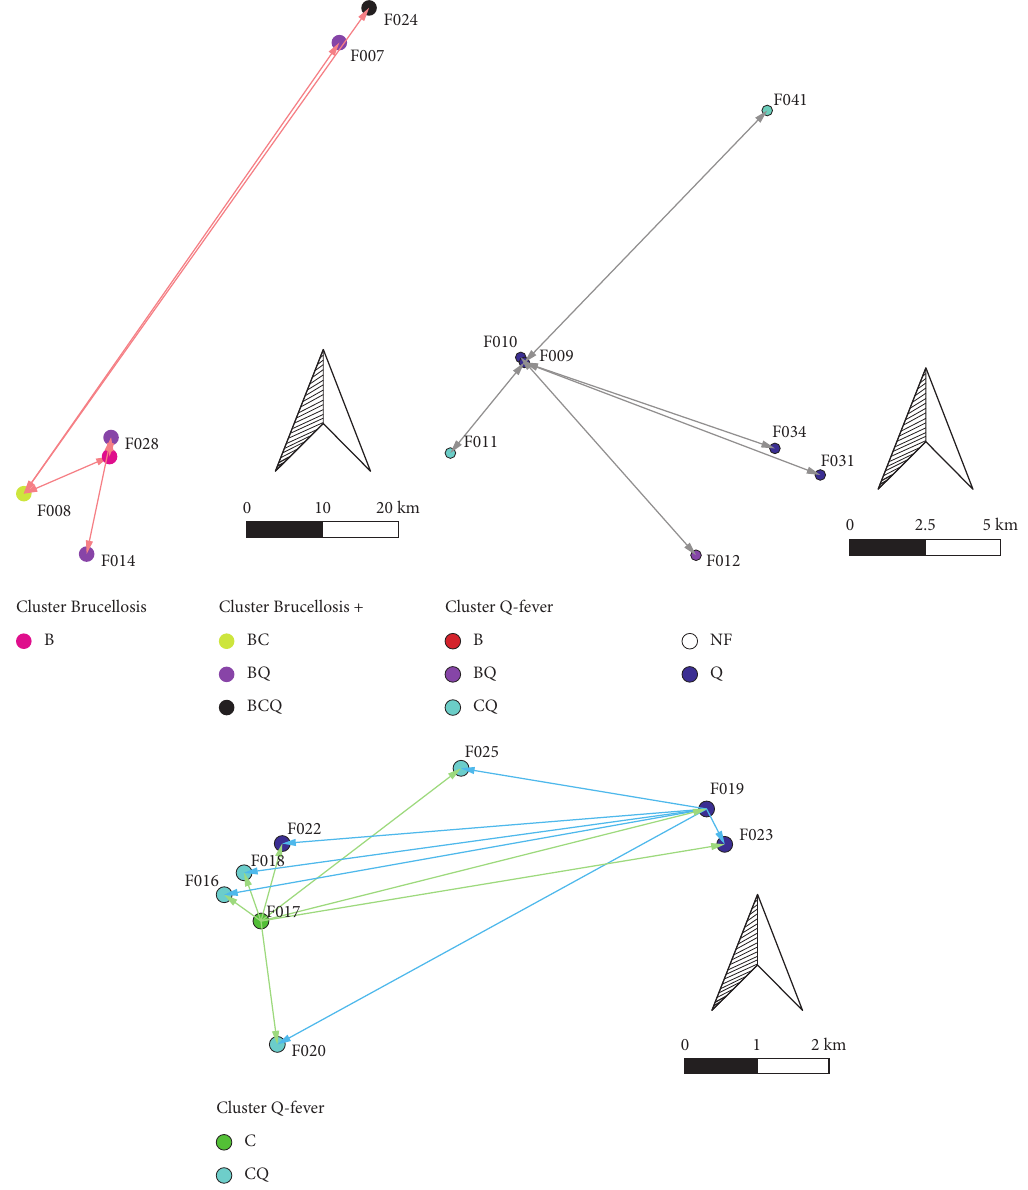
Figure 5: Cluster surge of brucellosis, Q fever, and chlamydiosis across herds within three communities due to shared buck